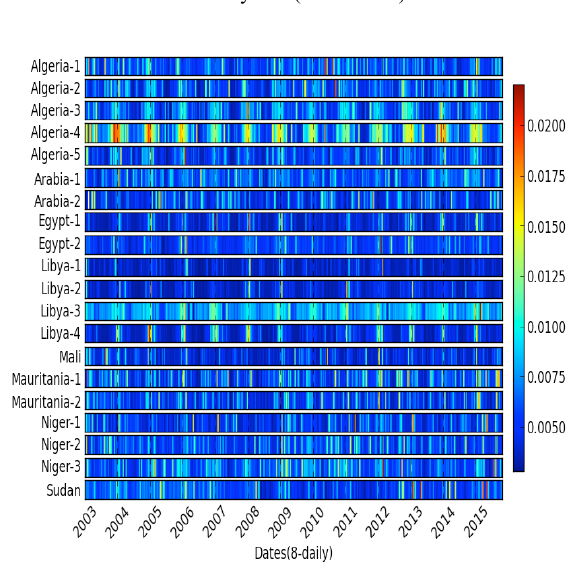
Figure 2. Coefficient of variation of WSA within the 10x10km window. It represents the temporal variation of the spatial homogeneity, 8 daily for 13 years